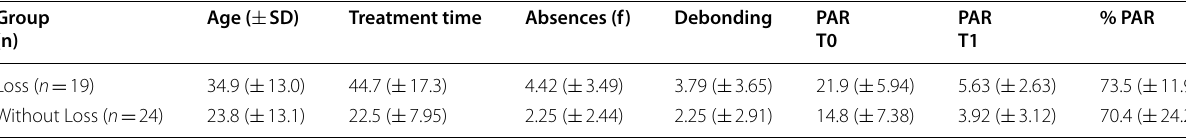
Table 1 Mean and standard deviation (SD) for age at T0, treatment time, number of absences, number of orthodontic appliance breakages, PAR at T0 and T1, % PAR corrected in groups with loss and without loss Group Age ( ± (n)